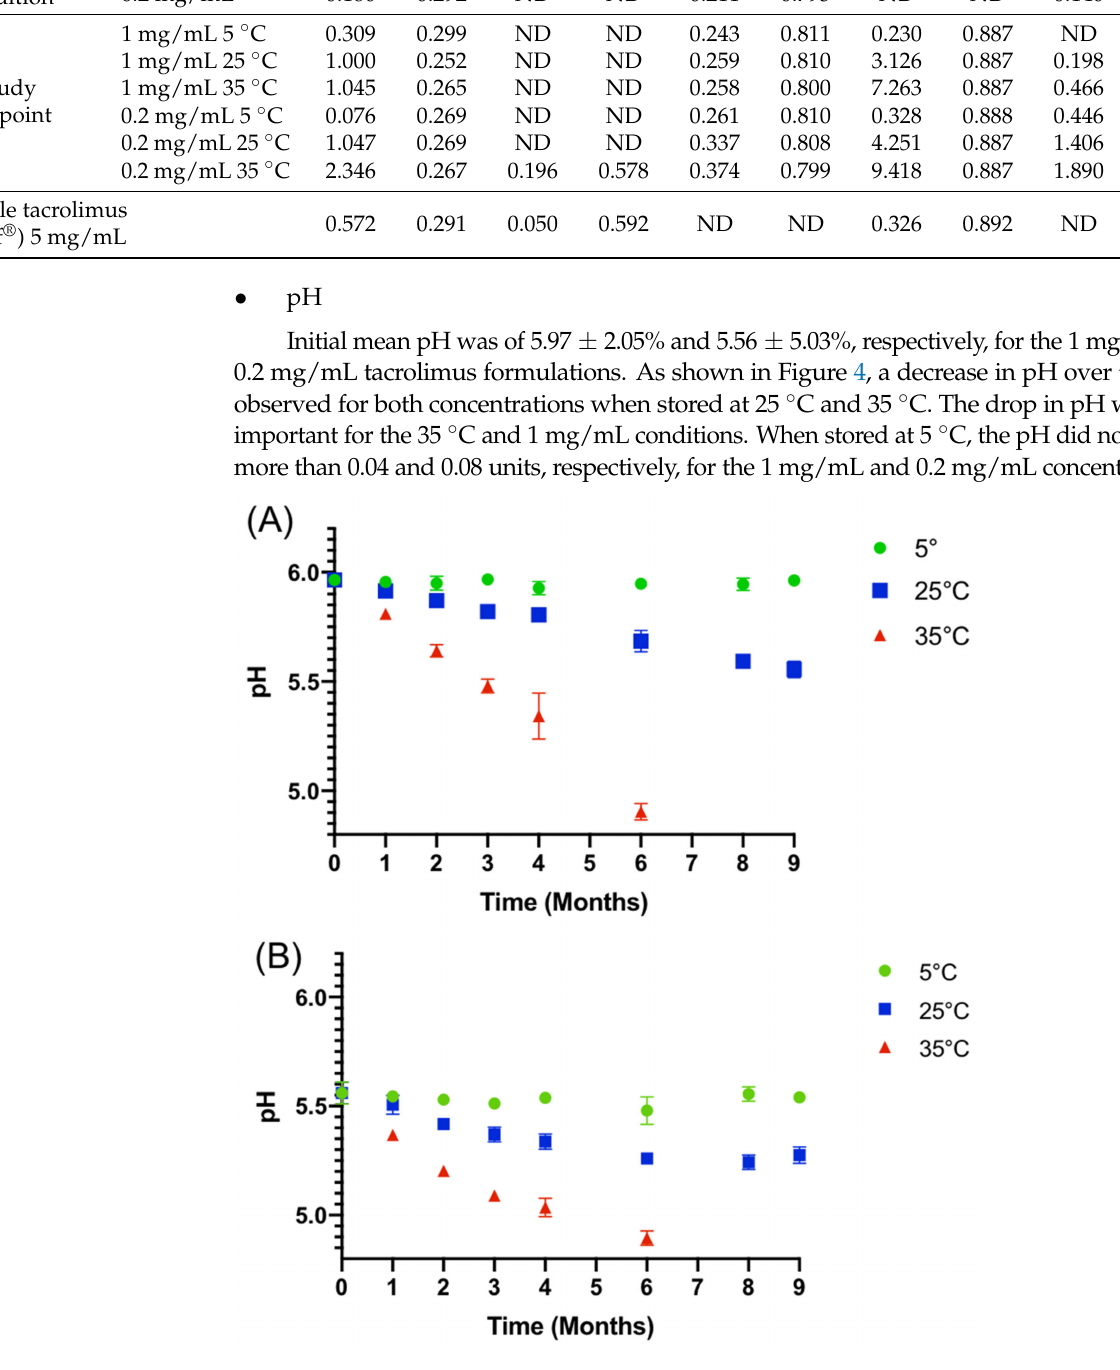
Figure 4. Evolution of the mean pH ( ± IC 95%) for nine months of storage at various temperatures with ( A ) 1 mg/mL tacrolimus formulation and ( B ) 0.2 mg/mL tacrolimus